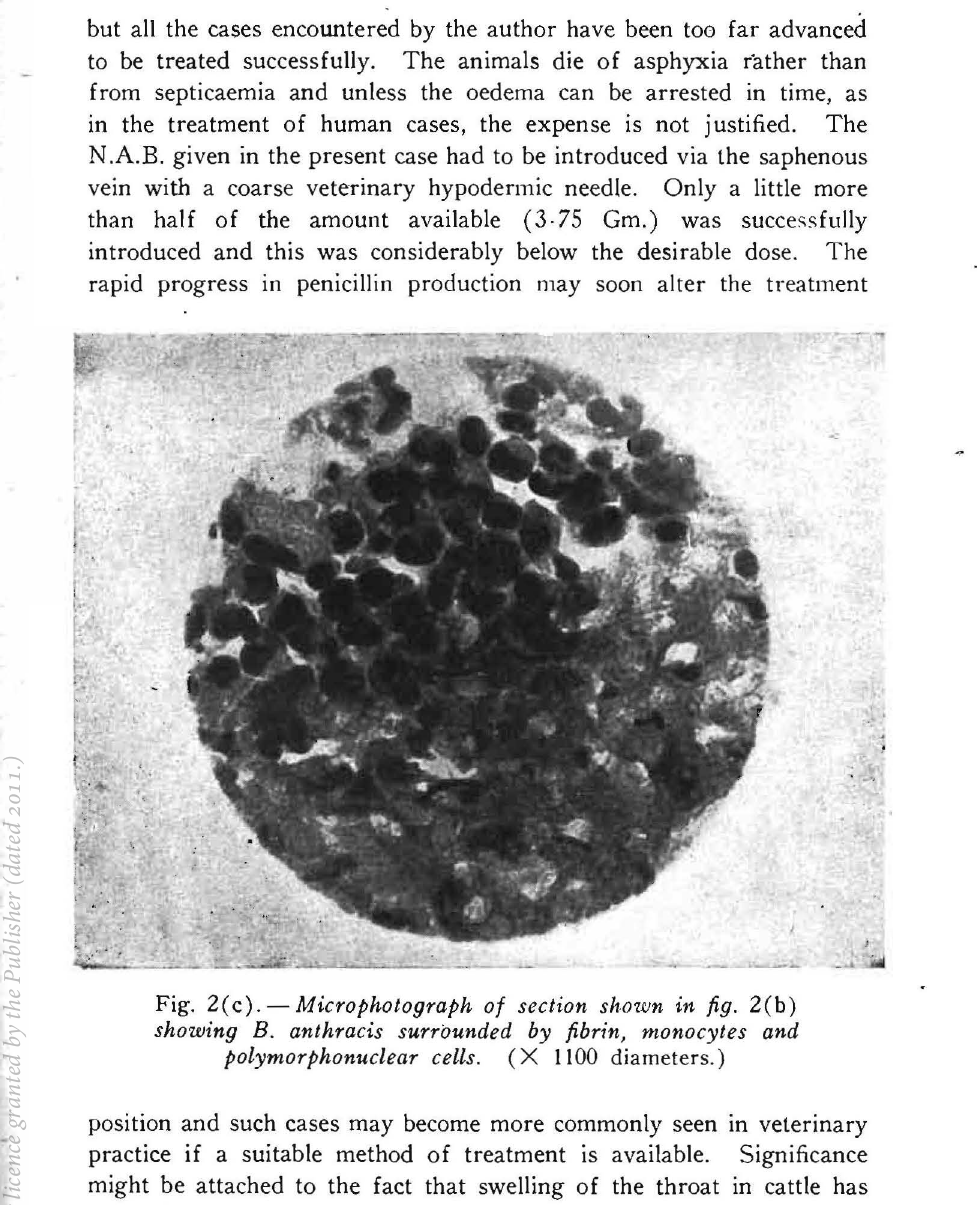
showing B. anthracis surrounded by fibrin, monocytes and polymorphonuclear cells. (X 1100